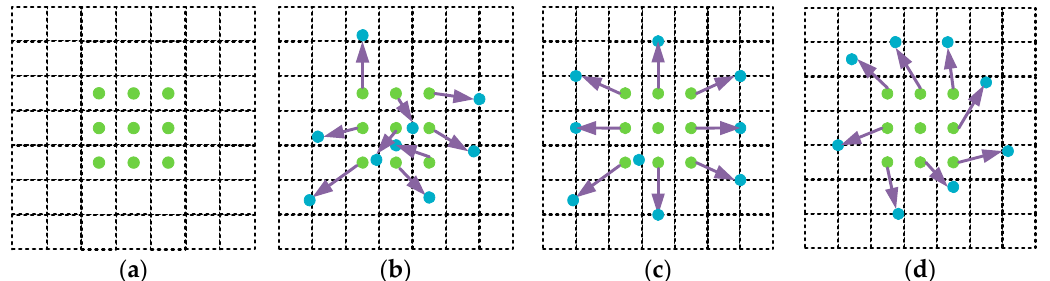
Figure 1. 3 × 3 Illustration of sampling positions in standard and deformable convolution, ( a ) standard convolution of the sampling point arrangement rule (green dot), ( b ) the sensing field sampling position after the deformable convolution plus offset, and ( c , d ) are special cases of ( b ) showing that deformable convolution can cope with a variety of situations such as scale and rotation.